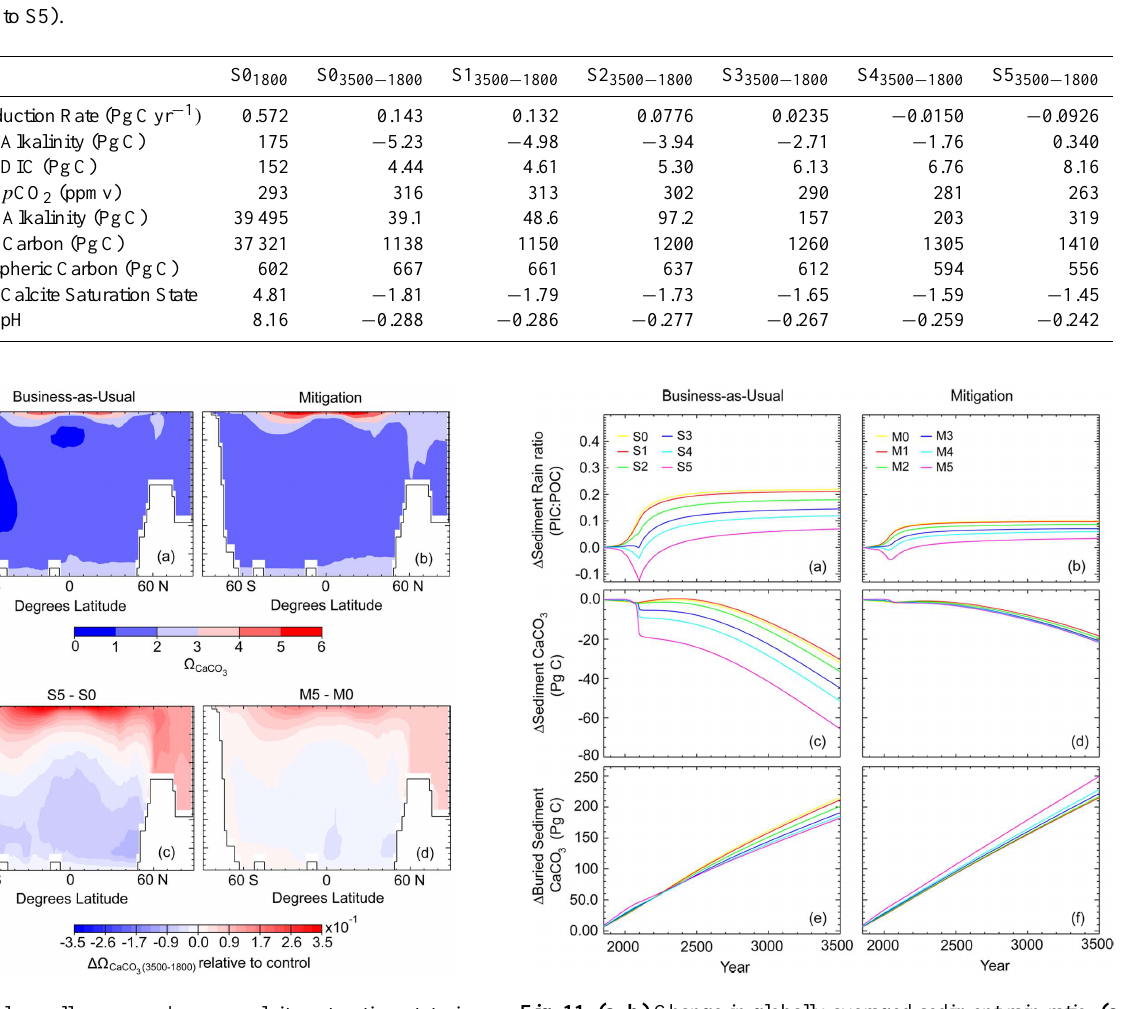
Fig. 11. (a, b) Change in globally averaged sediment rain ratio, (c, Fig. 10. Global zonally averaged ocean calcite saturation state in d) the total CaCO 3 -carbon in the sediment bioturbated layer, year 3500 for (a) run S0 and (b) run M0 and the global zonally av- eraged change in 1(cid:127) CaCO relative to control (scenario 3 ( 3500 − 1800 ) 0) for (c) run S5 and (d) run M5 respectively.